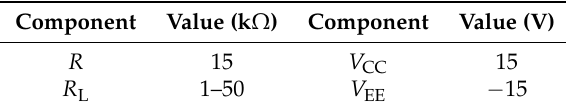
Table 1. Component values for the Lockhart wavefolder